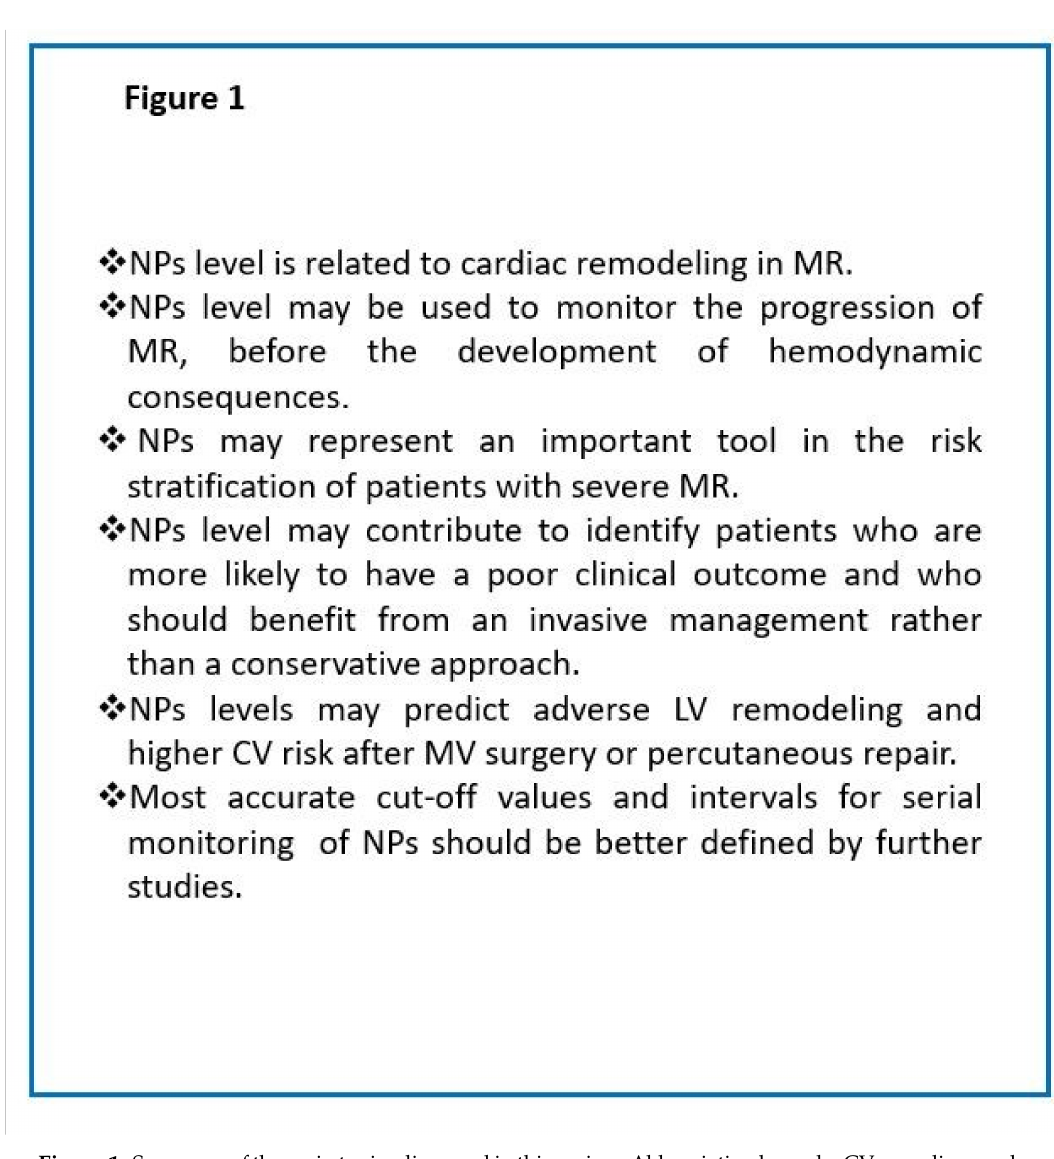
Figure 1. Summary of the main topics discussed in this review. Abbreviation legends: CV = cardiovascular; MR = mitral regurgitation; MV = mitral valve; NPs = natriuretic